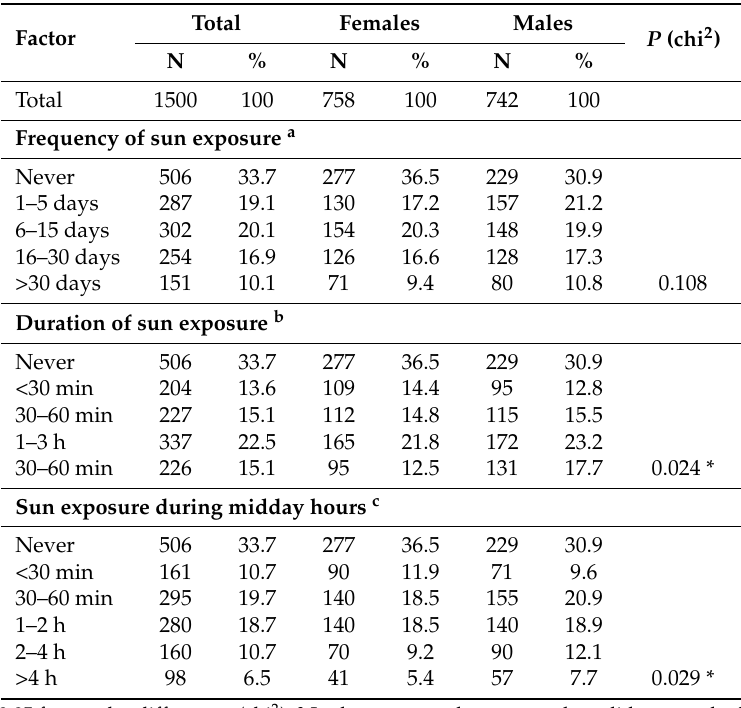
Table 1. Sun exposure prevalence (frequency, duration, and during midday hours), stratified by gender. Total Females Males Factor